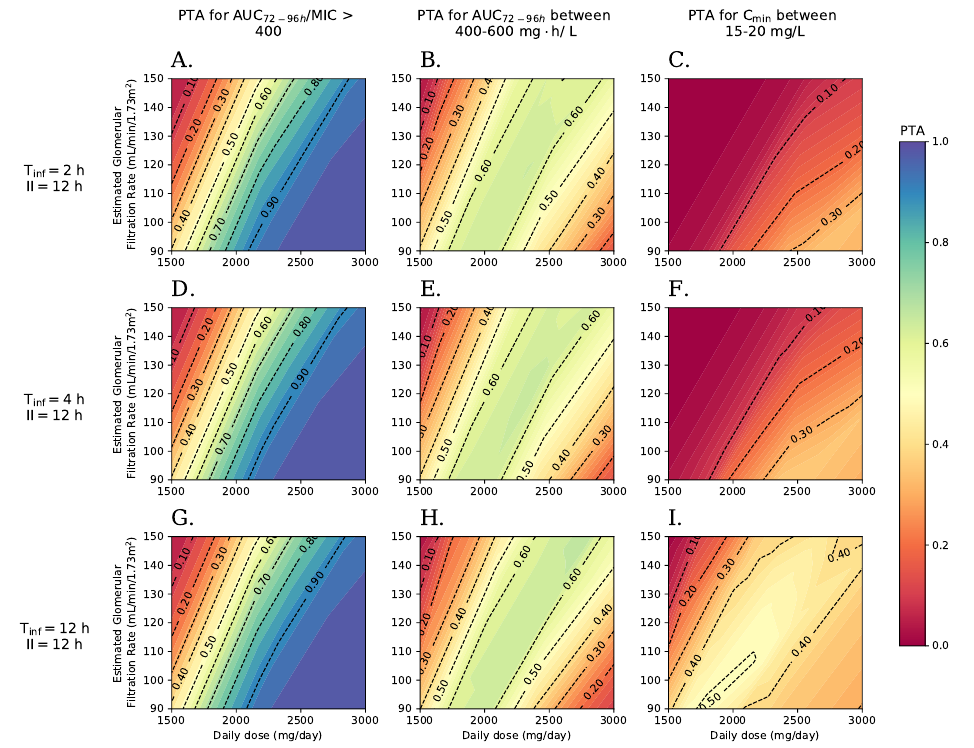
Figure 4. Response surface plots for PTA of explored PK/PD indices. ( A , D , G ) PTA for index AUC 72 − 96h /MIC ≥ 400 for times of infusion of 2, 4, and 12 h respectively. ( B , E , H ) PTA for index AUC 72 − 96h between 400–600 mg · h/L for times of infusion of 2, 4, and 12 h respectively. ( C , F , I ) PTA for indicator C SS between 15–20 mg/L for times of infusion of 2, 4, and 12 h respectively. The evalu- min ated VAN dosing schemes presented a 12-h period as II, T inf with 2 h and MIC of 1 mg/L only for the AUC/MIC